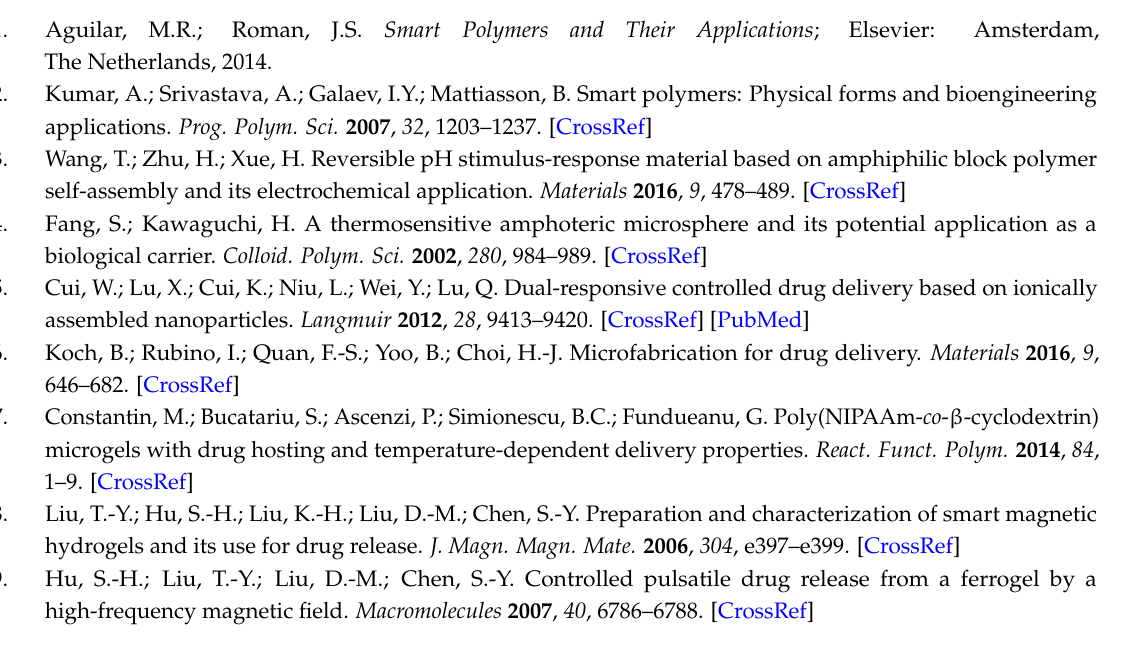
Figure S1: Calibration curves of atorvastatin in: (a) deionized water; (b) pH 2 buffer solution; and (c) pH 7.4 buffer solution. Figure S2: Encapsulation efficiency (%) of various initial amount of atorvastatin for sample CDg-0. Figure S3: Encapsulation efficiency (%) of atorvastatin for various hydrogel